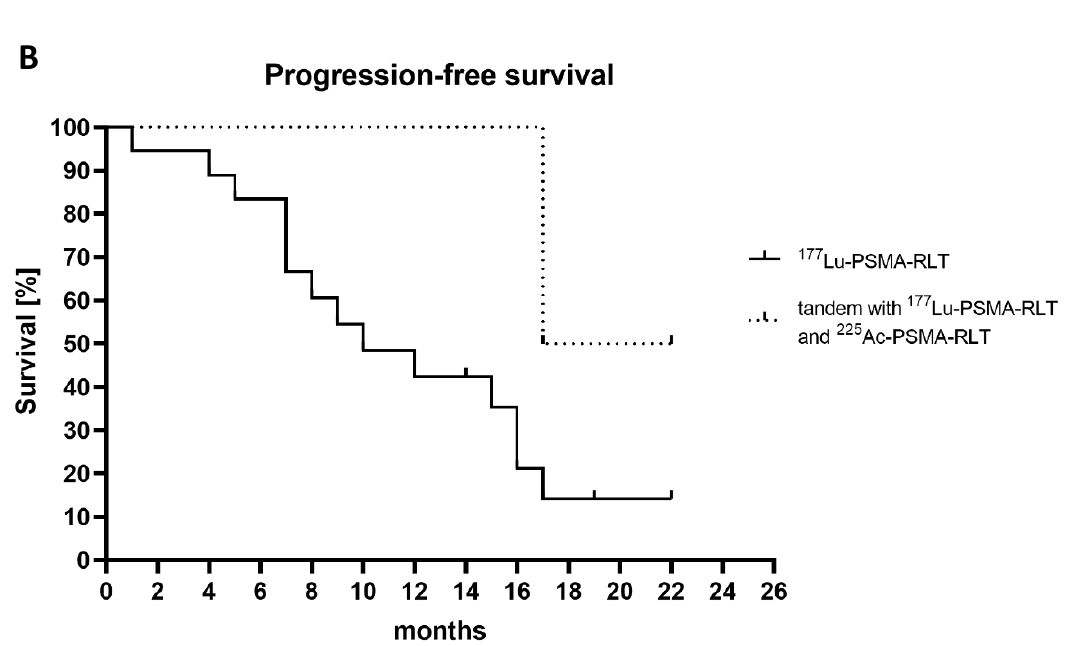
Figure 3. Survival analysis of progression-free survival in all early-stage prostate cancer patients. ( A ) The median PFS is 15 months in all mHSPC patients. ( B ) Stratified to 177 Lu-PSMA ( n = 18) vs. tandem of 177 Lu-PSMA and 225 Ac-PSMA ( n = 2), the median PFS was 12 and 17 months respectively. mHSPC = metastatic hormone-sensitive prostate cancer; PFS = progression-free survival; PSA = prostate specific antigen; PSMA = prostate specific membrane antigen .